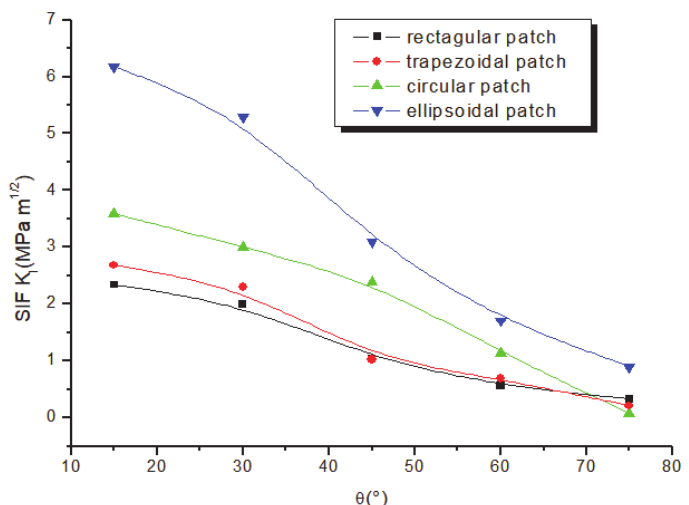
Figure 13: Variation of the (SIF) in mode I of the inclined crack for the different shape of patch (a = 30 mm)